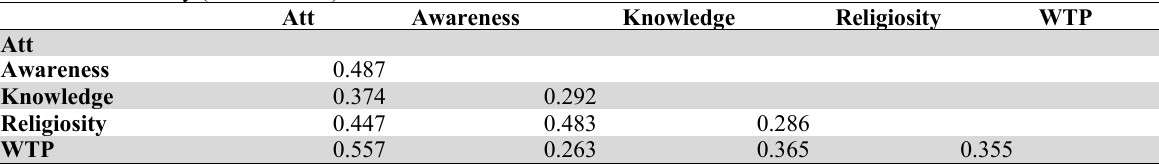
Discriminant Validity (HTMT Ratio)